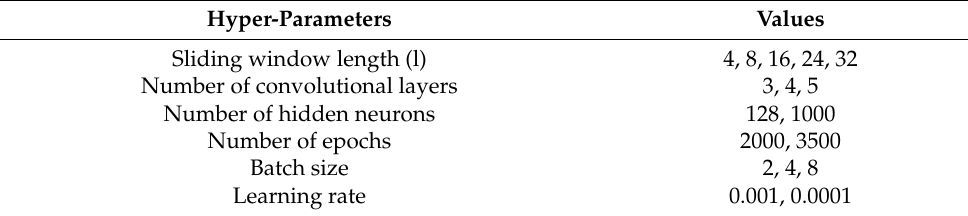
Figure 6. An example of transforming a microstructure into multiple 3D mini microstructures using a sliding window of length = 6 and stride = 1. Table 2. Hyper-parameters configuration of 3D CAEs using 3D mini microstructures.